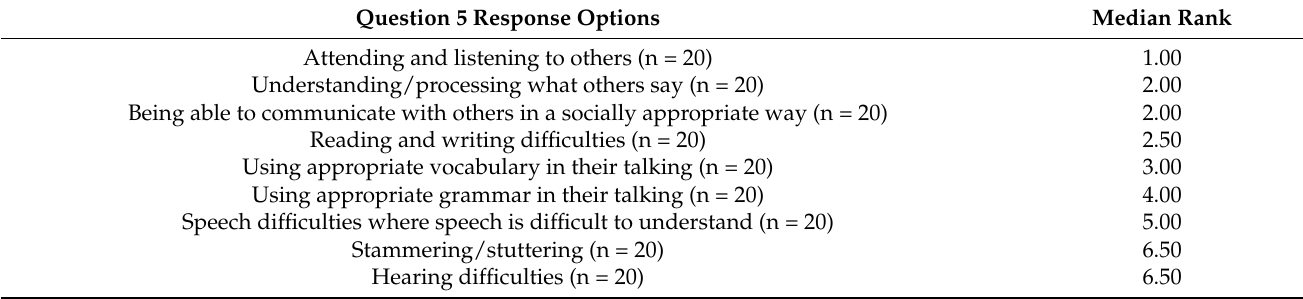
Table 6. Survey: Question 5. What types of communication difficulties do care leavers have? Respondents ranked 9 options from 1–9 where 1 represented the type of need most prevalent and 9, the type of need the least prevalent (n = 20/23 responses).